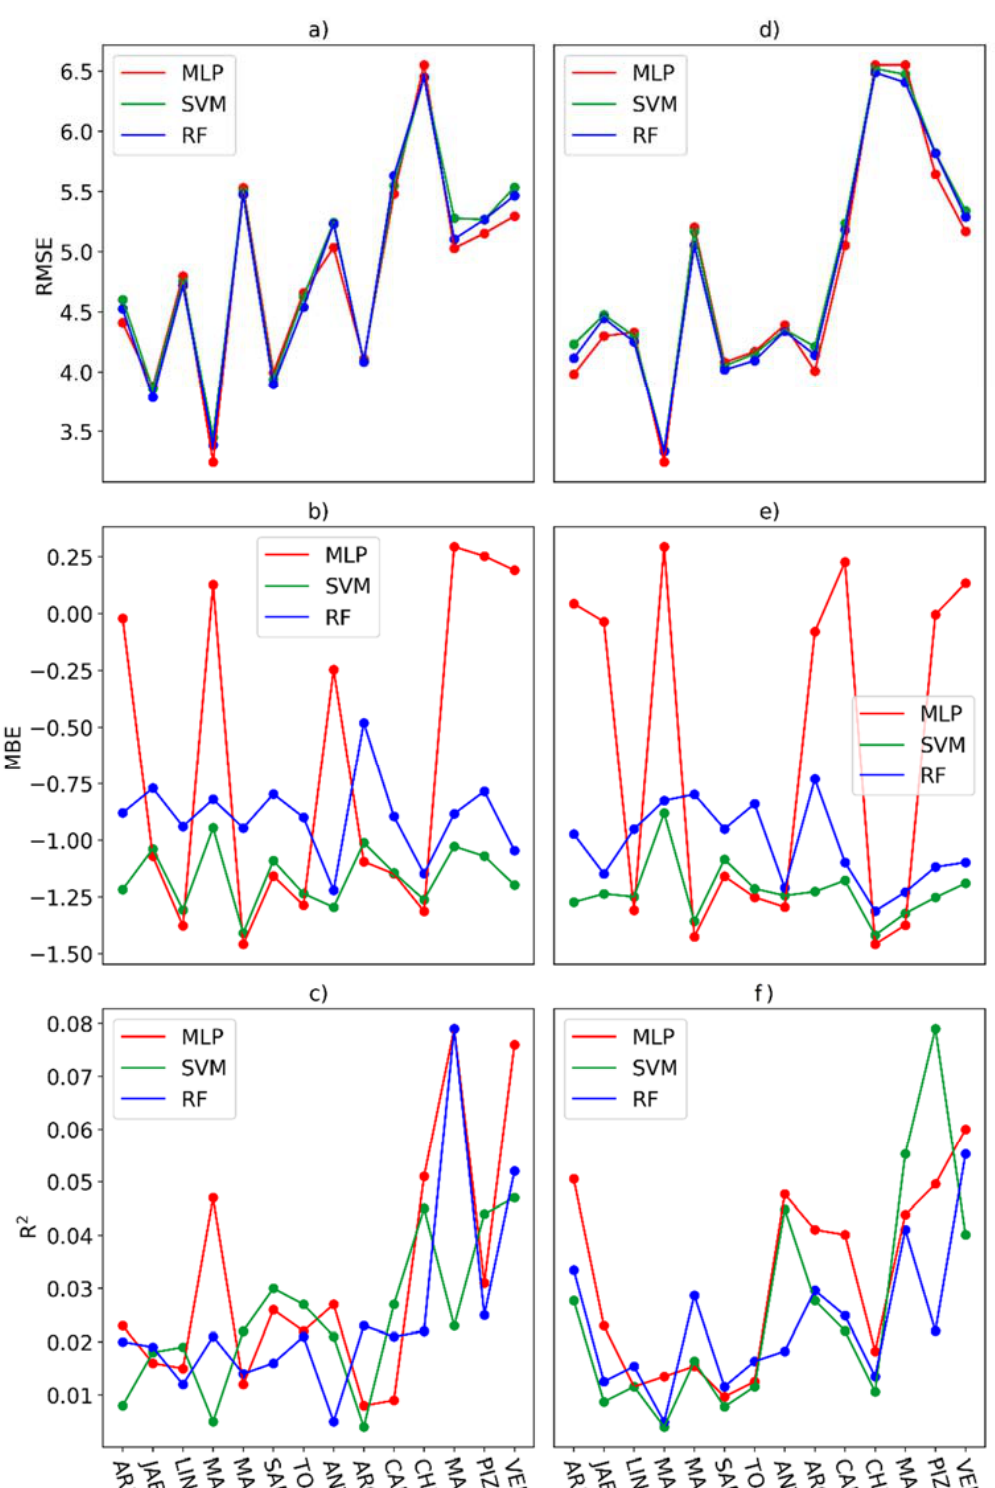
Figure 6. RMSE, MBE, and R 2 values from testing dataset for all stations and models (MLP, SVM, and RF), using only precipitation data from the target station. ( a ) RMSE using approach B, ( b ) MBE using approach B, ( c ) R 2 using approach B, ( d ) RMSE using approach C, ( e ) MBE using approach C, ( f ) R 2 using approach C.